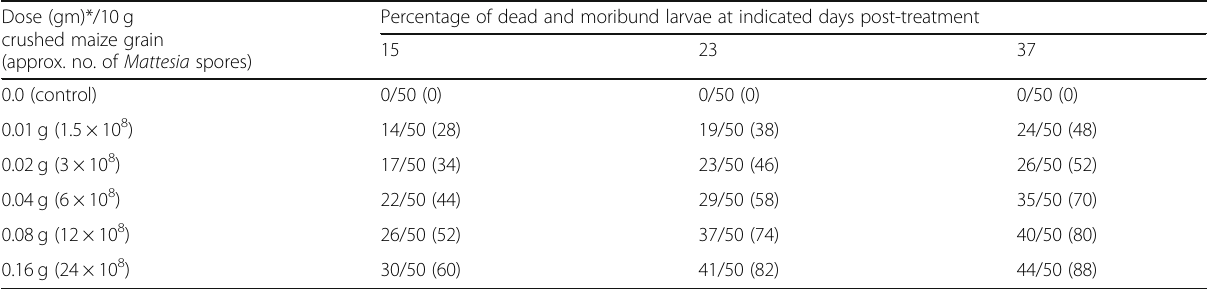
*Powdered cadavers (in gm) of Laemophloeus turcicus adults (0.01g ≃ 100 cadavers carried ca. 1.5×10 8 Mattesia